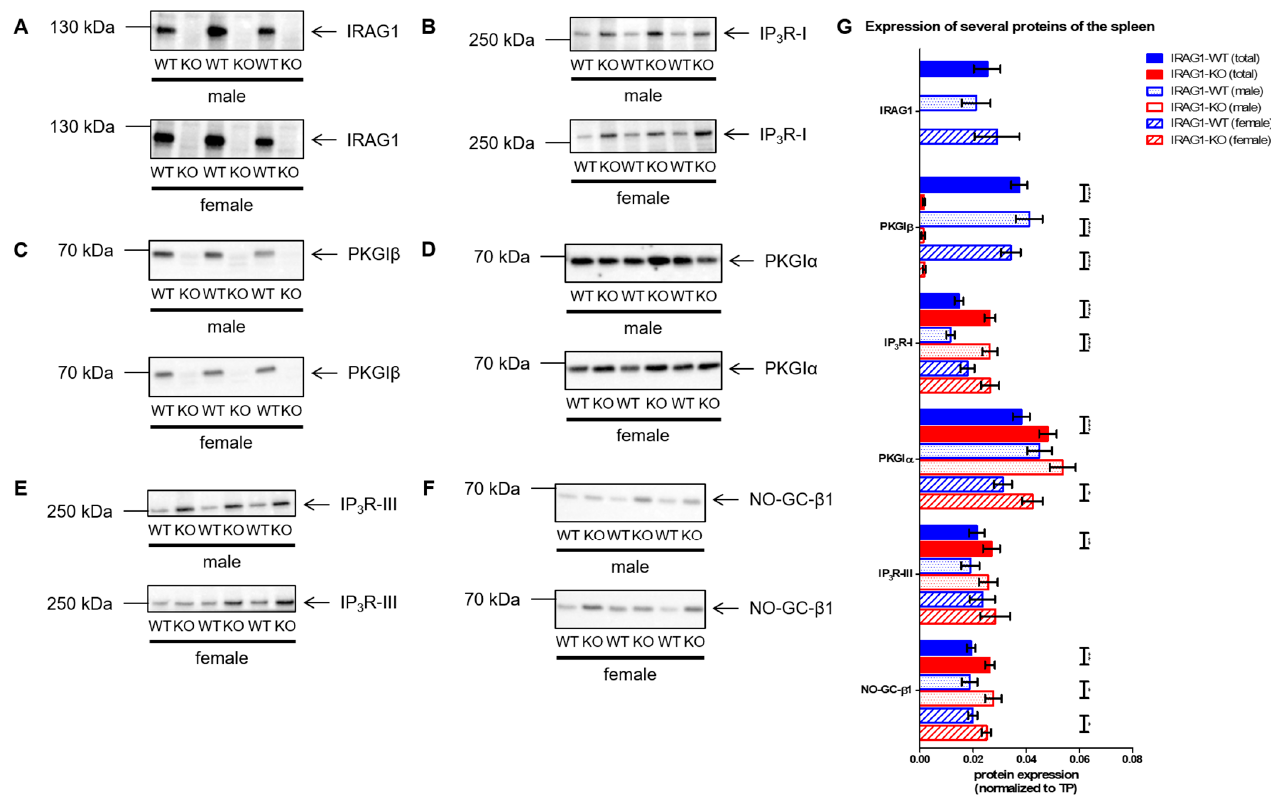
Figure 6. The expression of several cGMP/PKGI signaling proteins in spleens from IRAG1-KO (KO) and IRAG1-WT (WT) mice. Protein expression of IRAG1-KO mice and IRAG1-WT mice (respective age: 15 weeks) were analyzed by Western blot ( A – F ) and for quantification normalized to total protein (TP) ( G ). ( A ) Western blot of IRAG1 of male and female IRAG1-WT (total: n = 23; male: n = 11; female: n = 12) and IRAG1-KO mice (total: n = 24; male: n = 12; female: n = 12). ( B ) Increased expression of IP 3 R-I in IRAG1-KO mice (total: n = 22; male: n = 12; female: n = 10) compared to WT littermates